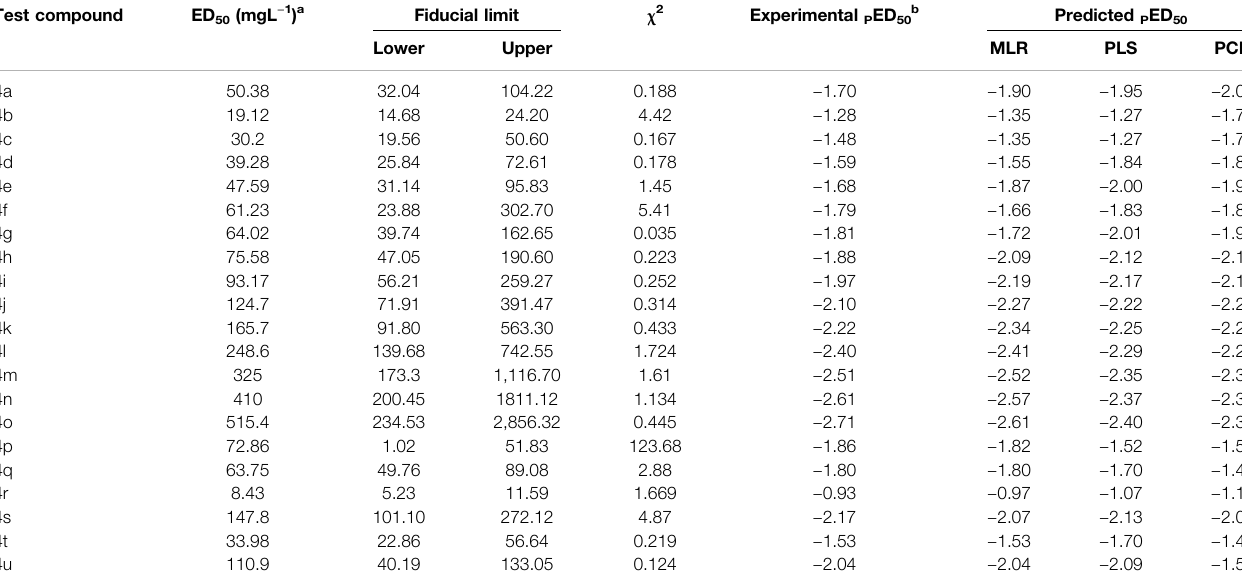
TABLE 3 | Experimental and predicted fungicidal activity of chromones. Test